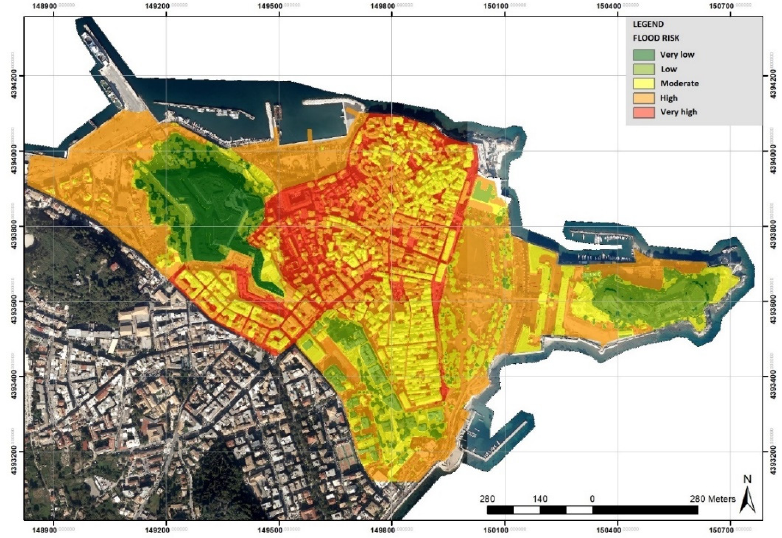
Figure 19. Flood risk map for the maximum rainfall rate of the climate scenario (2031–2060, RCP 8.5) .